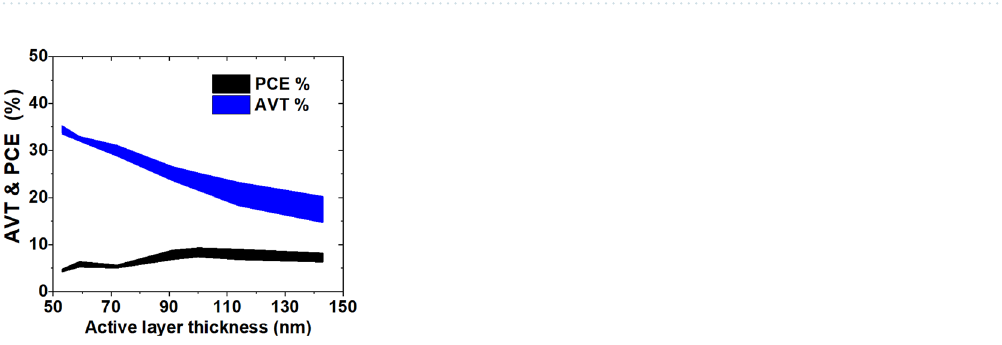
Figure 3. ( a ) The calculated transmittance spectrum of the active layer (100 nm), MoO 3 /Ag/MoO 3 , ITO with ZnO compact layer, the whole device, both theoretical (solid line) and experimental (dotted), AM1.5 spectral irradiance, and V ( (cid:31) ) . S AM 1.5 ( (cid:31) ) . ( b ) The calculated transmittance spectrum of the devices for different active layer thicknesses.